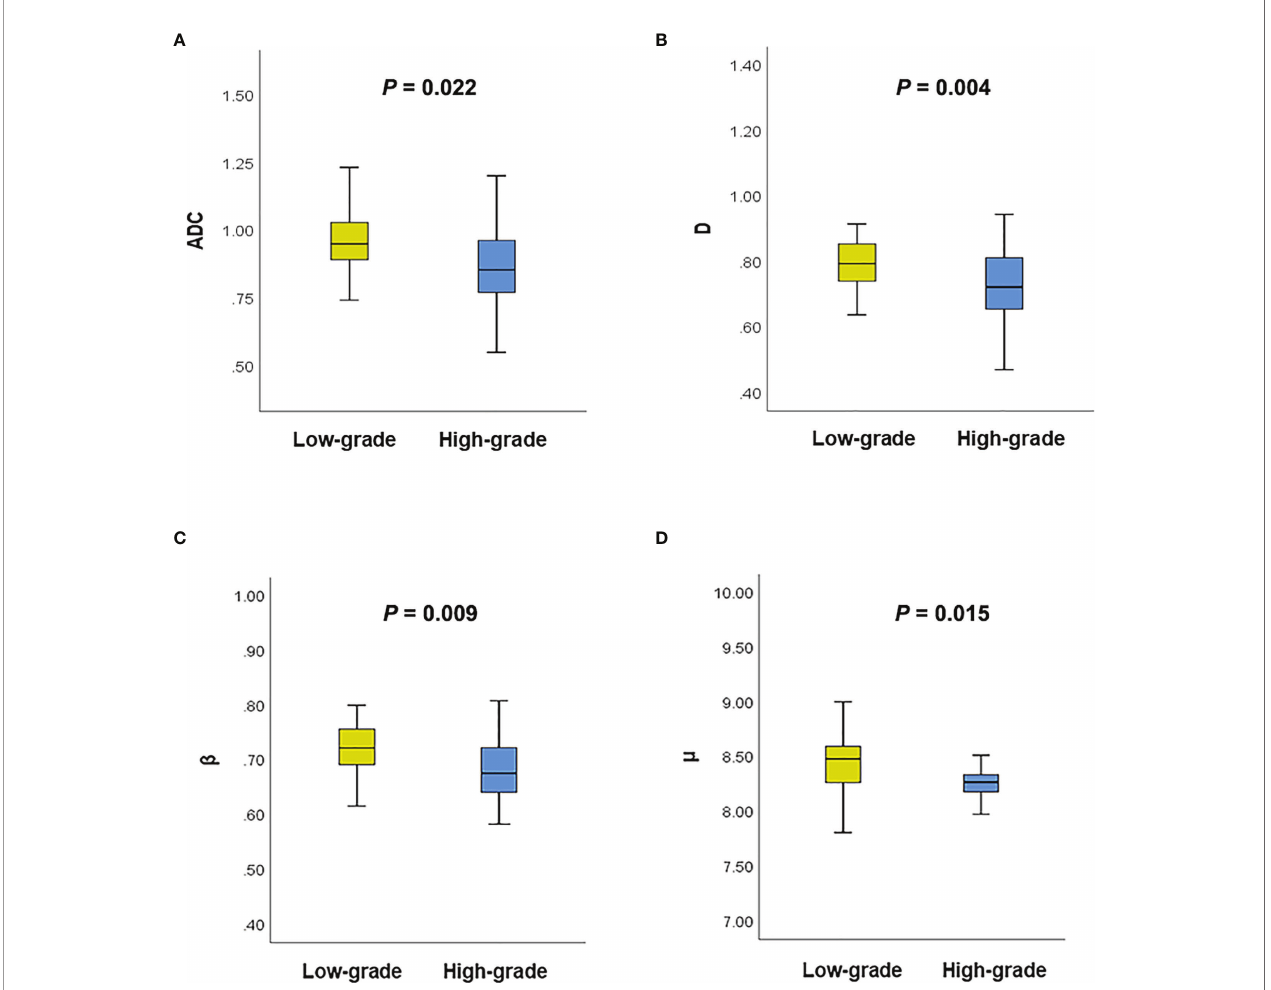
FIGURE 4 | (A) Comparison of the ADC between different tumor grades using the Mann – Whitney U test; (B) Comparison of the D between different tumor grades using the Mann – Whitney U test; (C) Comparison of the b between different tumor grades using the Mann – Whitney U test; (D) Comparison of the m between different tumor grades using the Mann – Whitney U